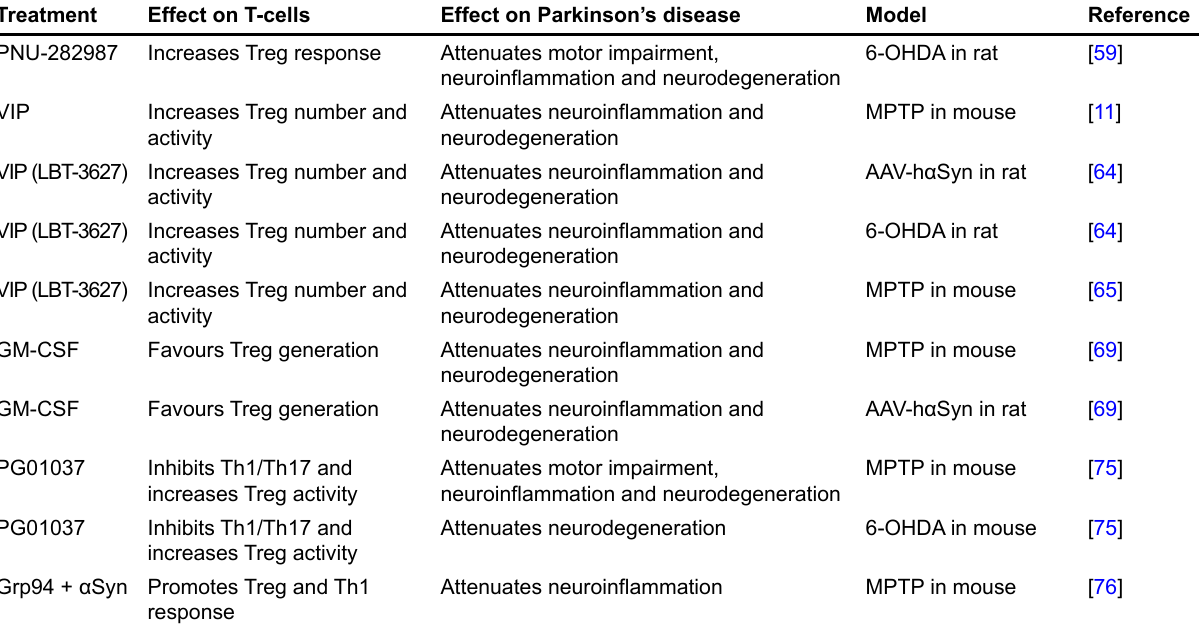
Table 1. Experimental T-cell-based immunotherapies tested in pre-clinical models of Parkinson’s disease ( continued )